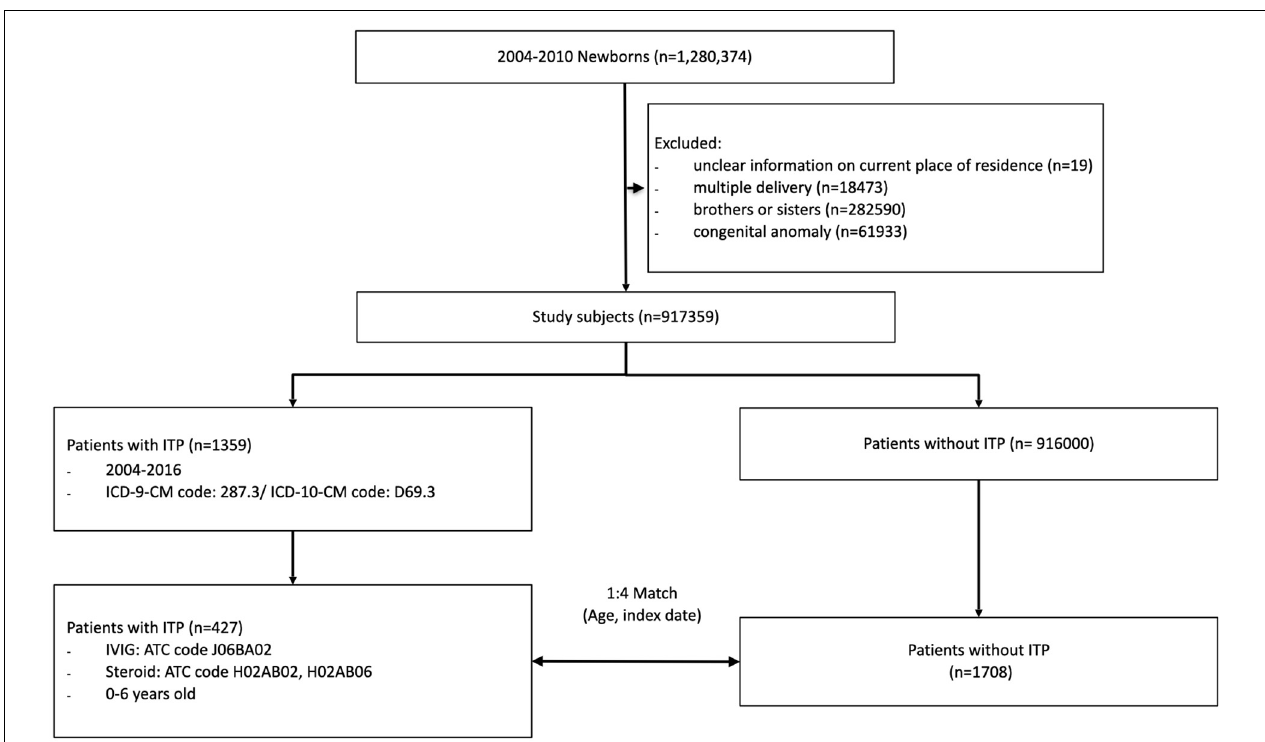
FIGURE 1 | Composition of the study